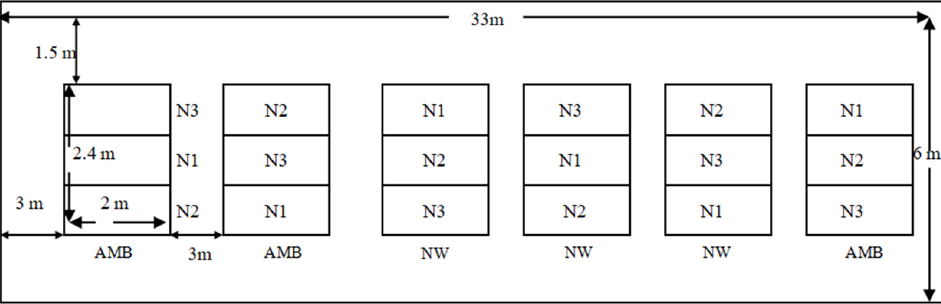
Figure 2. Experimental plot layout.